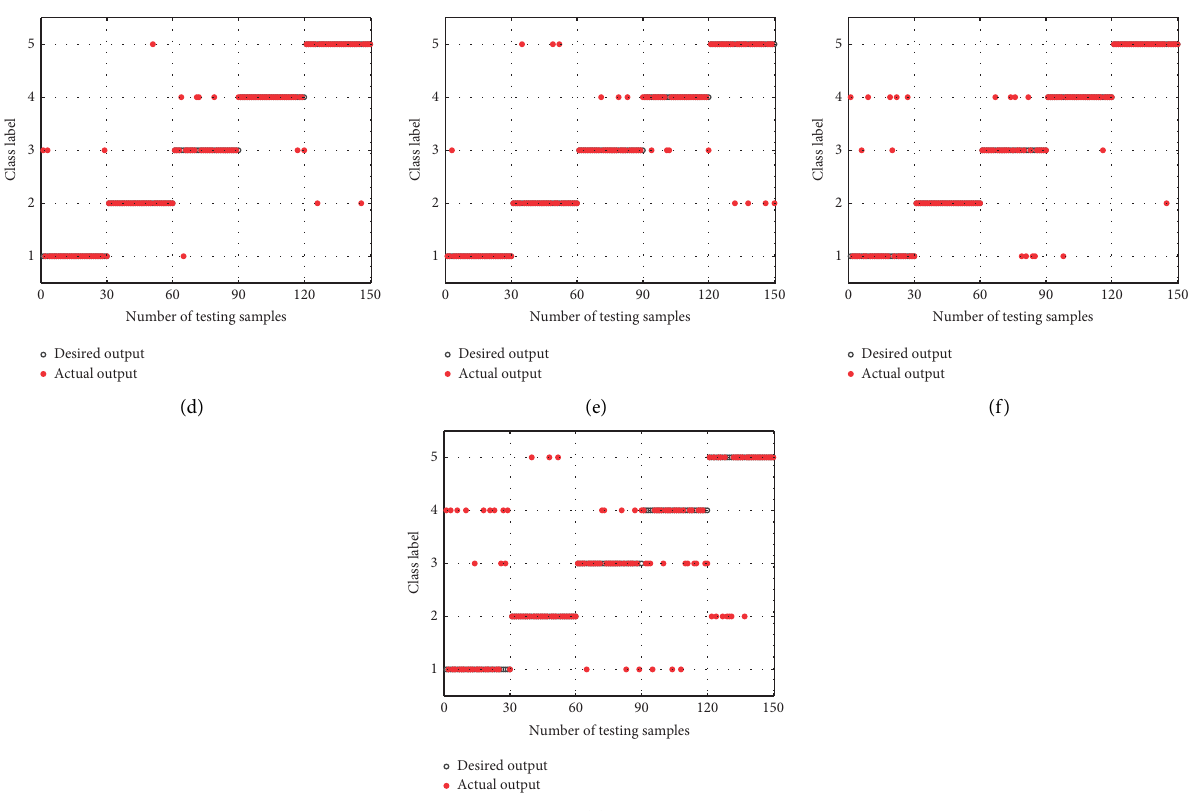
Figure 14: The recognition results corresponding to different feature extraction methods.